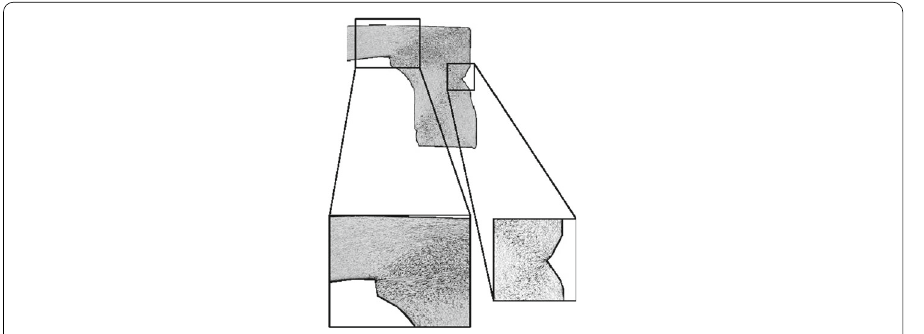
Fig. 12 Experimental observed grain structure of a bended blank after upsetting with the detailed views of two cavity defects